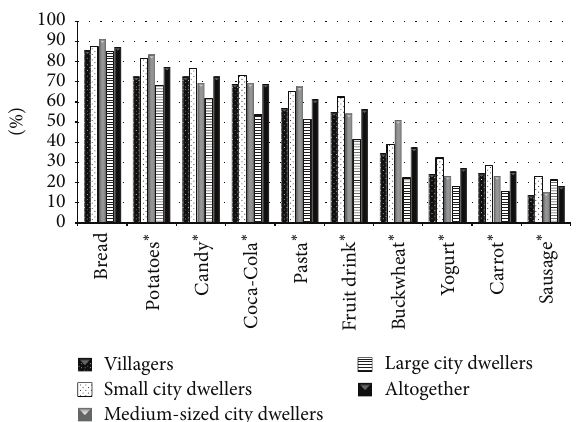
Figure2:Thelevelofphysicalactivitydeclaredbystudyparticipants (the “Intense exercise ( ... )” category not visible due to very small values).